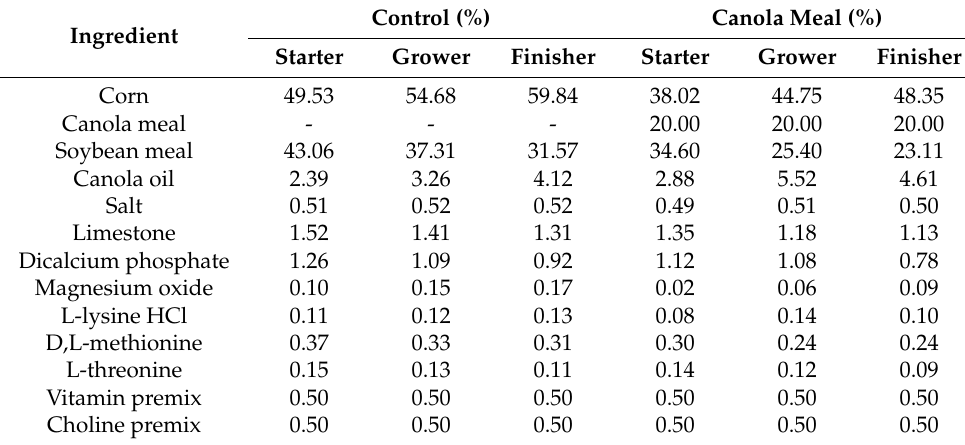
Table 1. Composition of the control and canola meal broiler